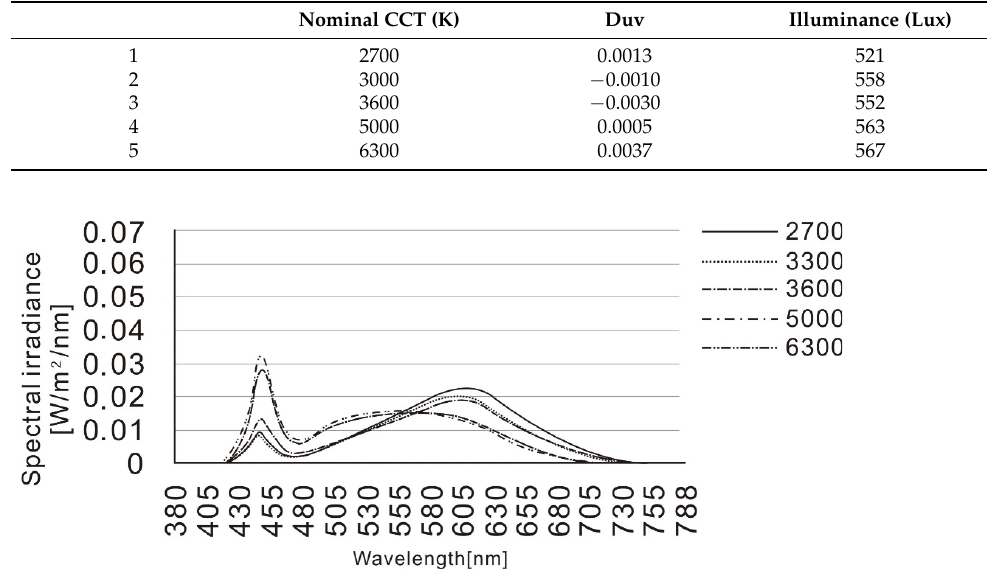
Figure 2. Spectral distribution of the light in the test room at nominal CCTs of 2700 K, 3000 K, 3600 K, 5000 K and 6300